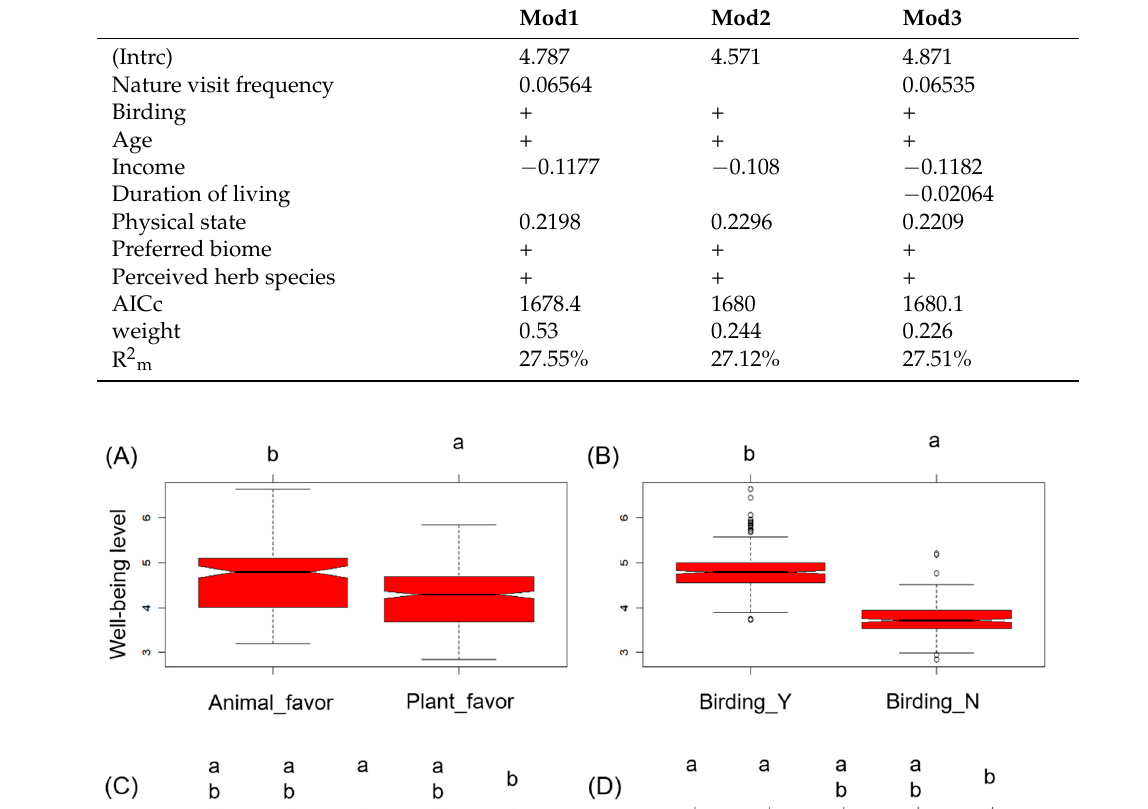
Table 2. Results of model selection analysis for residents’ psychological health based on AICc criterion. All the models are very significant ( p < 0.01) with a marginal R 2 ranging from 0.2712 to 0.2755. The ‘+’ stand for the significant effects of categorical variables. For descriptions for predictive variables, please see Table 1.